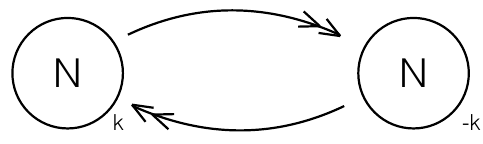
Figure 1 . The quiver diagram for the ABJM